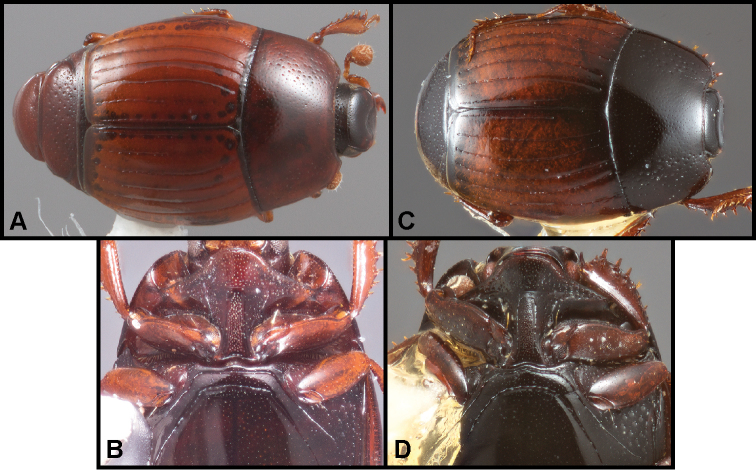
A–BPhelisterrufinotus Marseul: A Dorsal habitus B Prosternum and mesoventrite of male. C–DPhelisterthiemei Schmidt: A Dorsal habitus B Prosternum and mesoventrite of male.